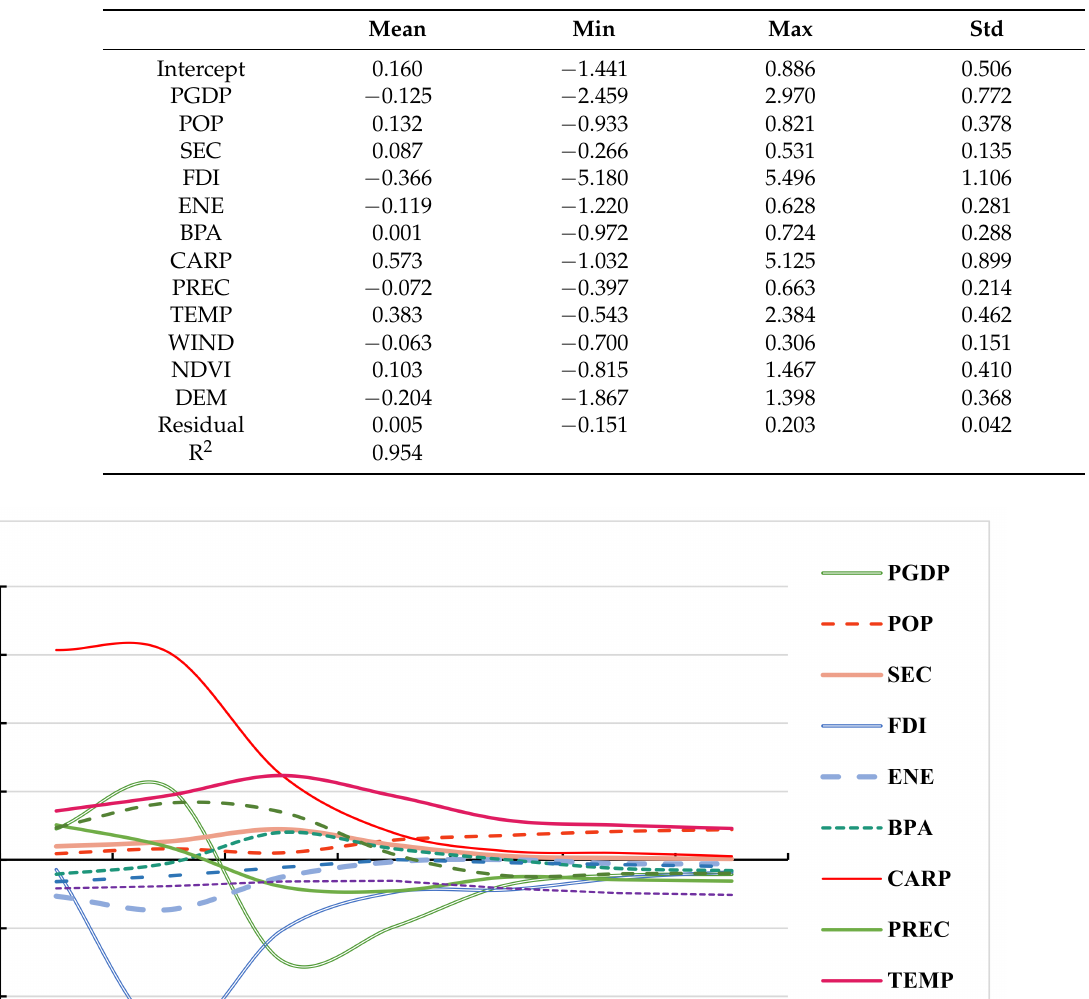
Table 5. Descriptive statistics of the GTWR standard coefficient of the independent variable.